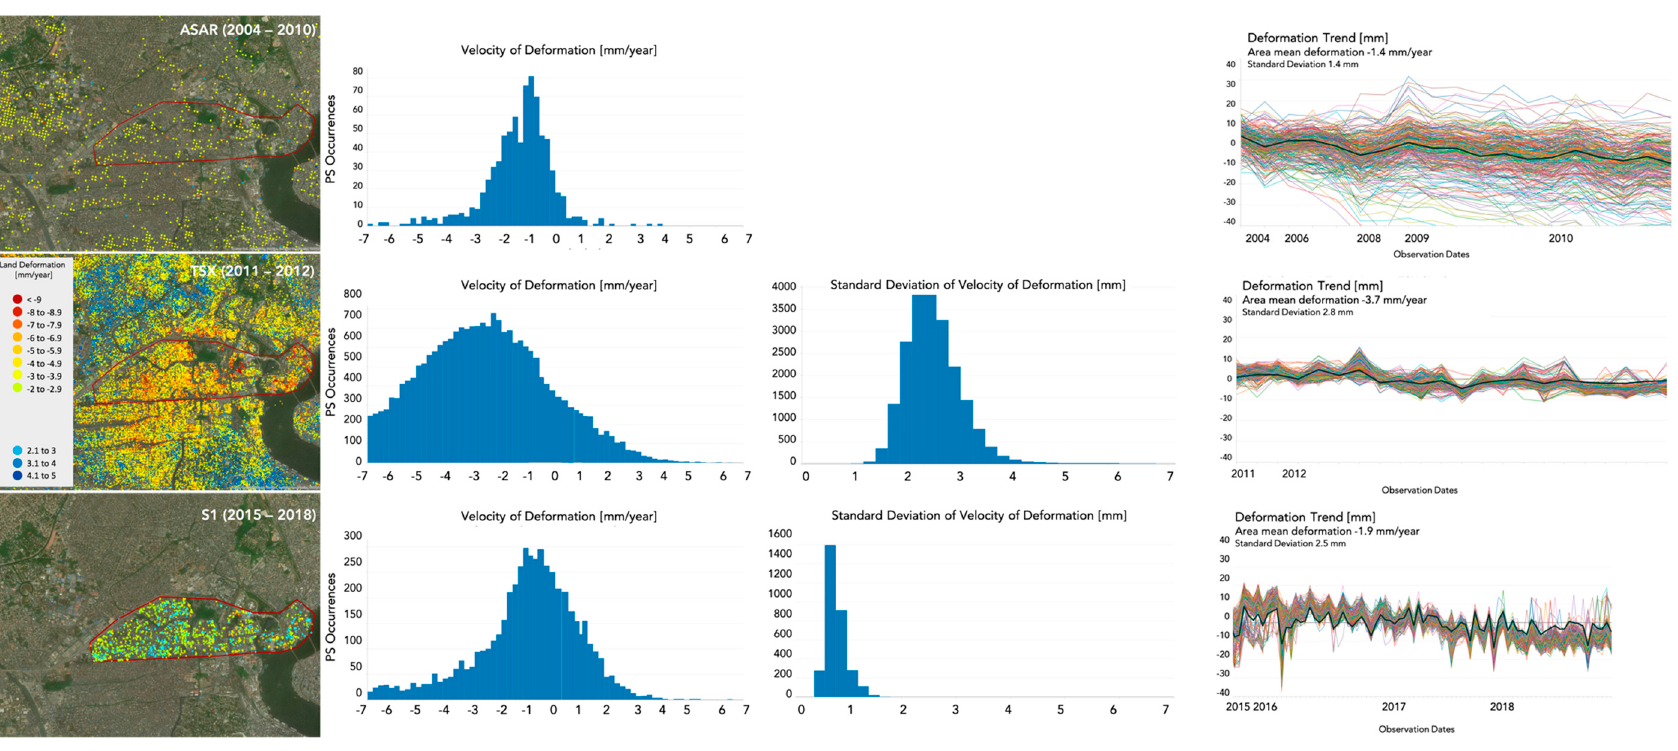
Figure 8 . Lagos AOI 3 Figure 8. Lagos AOI